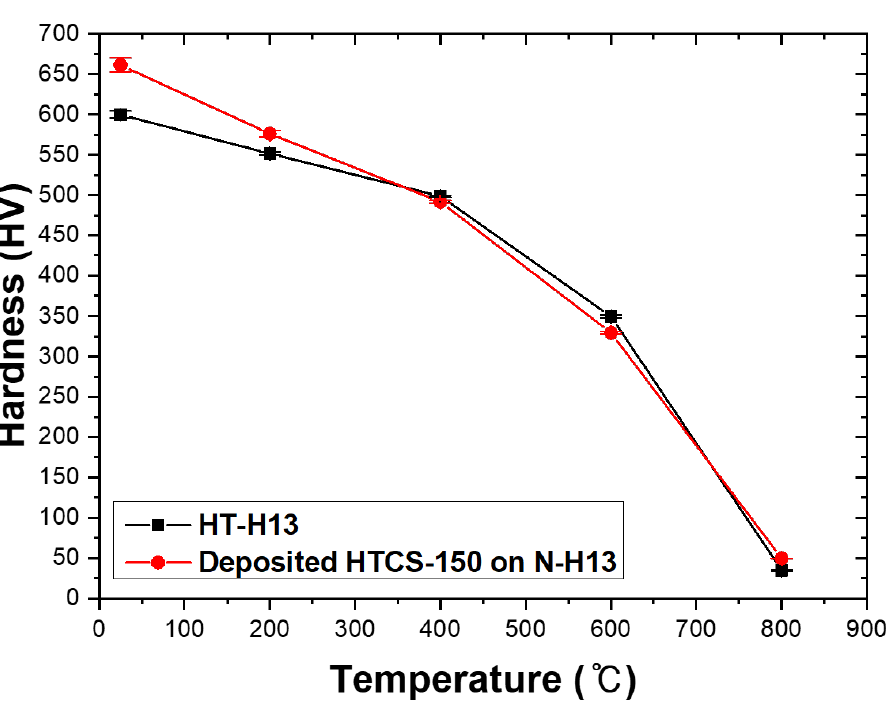
Figure 8. Hardness data of HT-H13 and the HTCS-150 deposited on N-H13 at elevated temperatures.